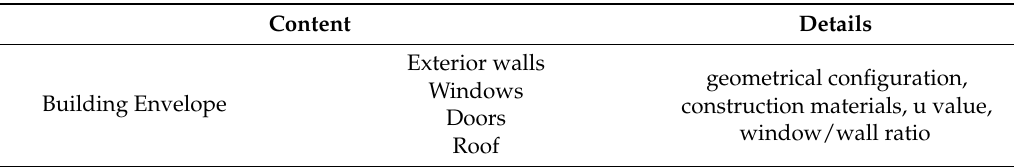
Table 3. The content of the energy audit.